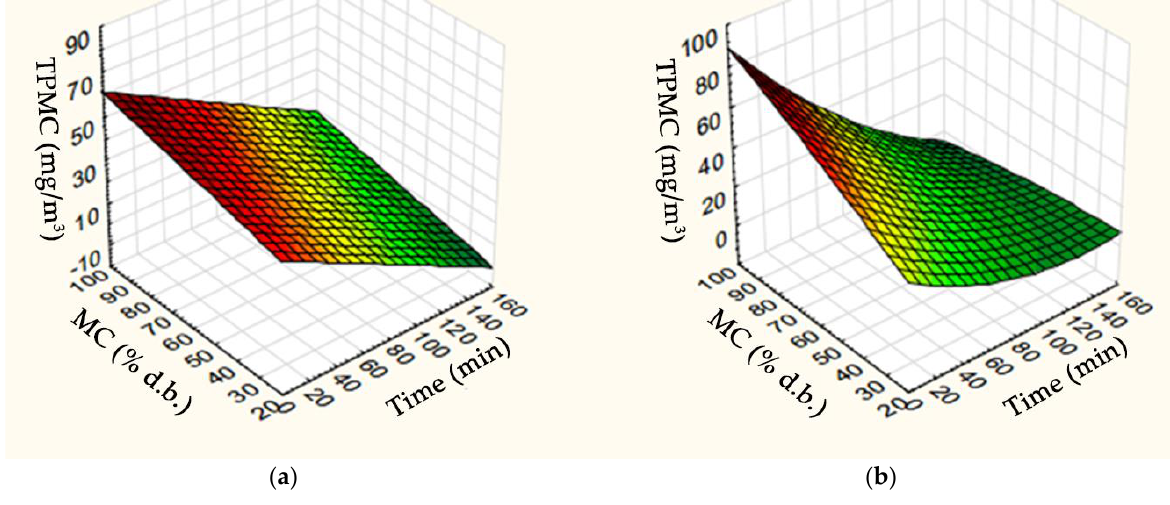
Figure 8. TPMC values ’ 3D surface plots by the first- and second-degree models: ( a ) First-degree model; ( b ) Second-degree model. Table 3. Coefficient values of first- and second-degree models of TPMC prediction.